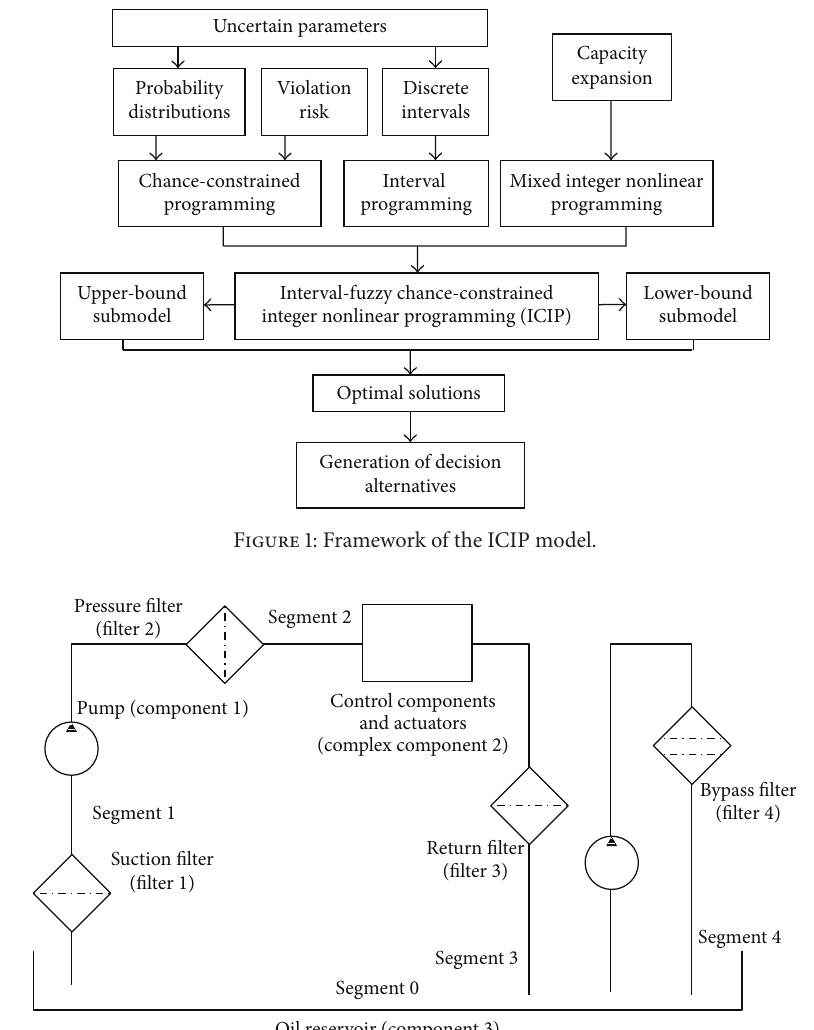
Figure 2: Typical hydraulic system with bypass filtration